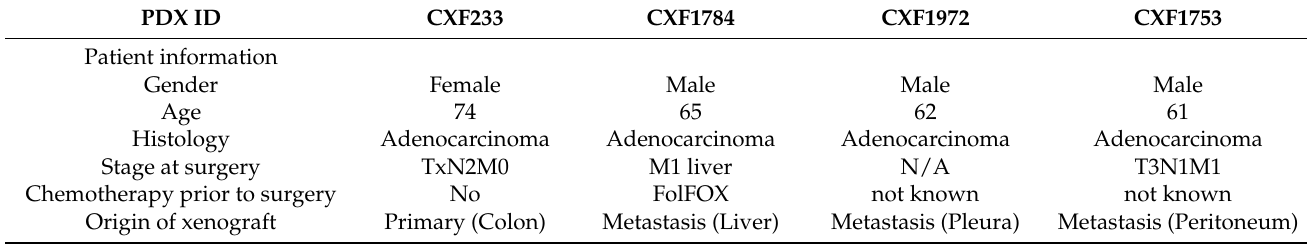
Table 1. Clinicopathological characteristics of the donor patients.